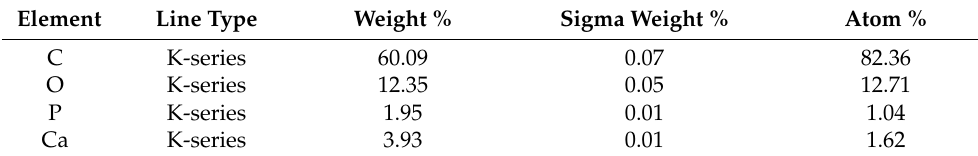
Figure 10. Layered image of EDX sample after 3 months: ( a ) SEM image of bone surface; ( b – e ) elemental maps. Table 2. Total spectrum of map and distribution of elements after 3 months.